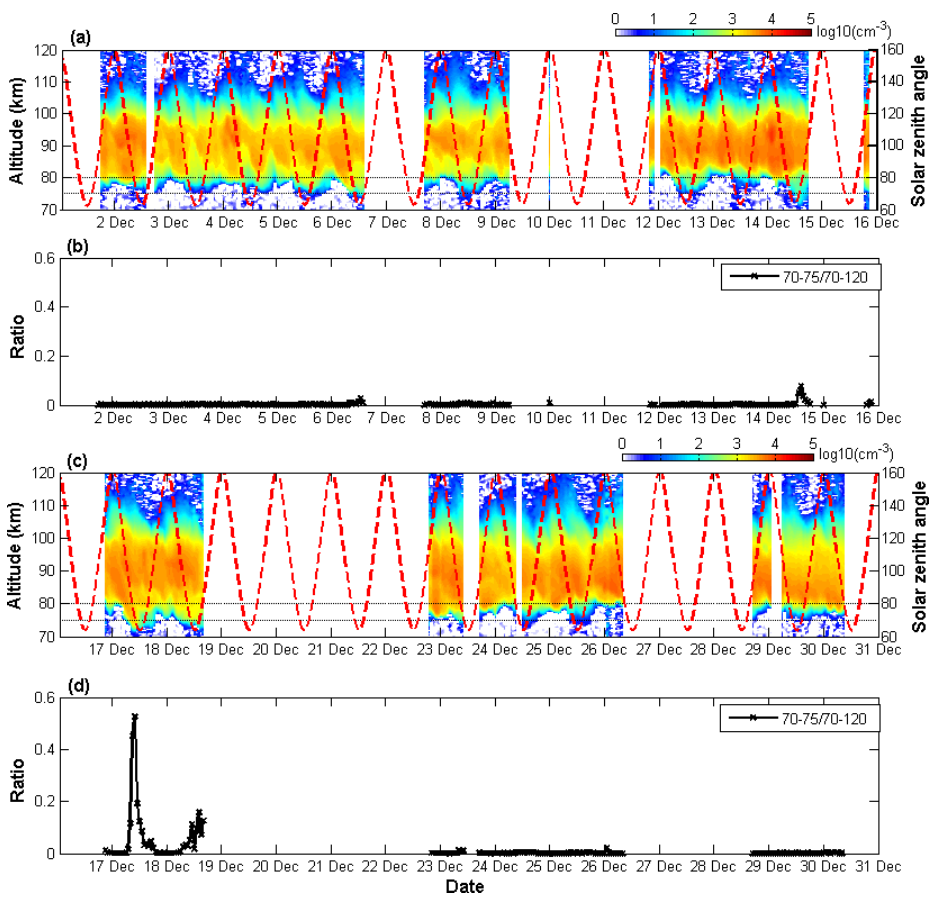
Figure 1. (a, b) The time–height evolution of Na density and the corresponding temporal variation of the ratio of Na density averaged in the altitude range of 70–75km to that within 70–120km on 3–9 December 2014. (c, d) The same but on 12–18 December 2014. The solar zenith angle is plotted with red dotted curves in (a) and (c) . The two black dashed lines in (a) and (c) denote 80 and 75km, respectively.